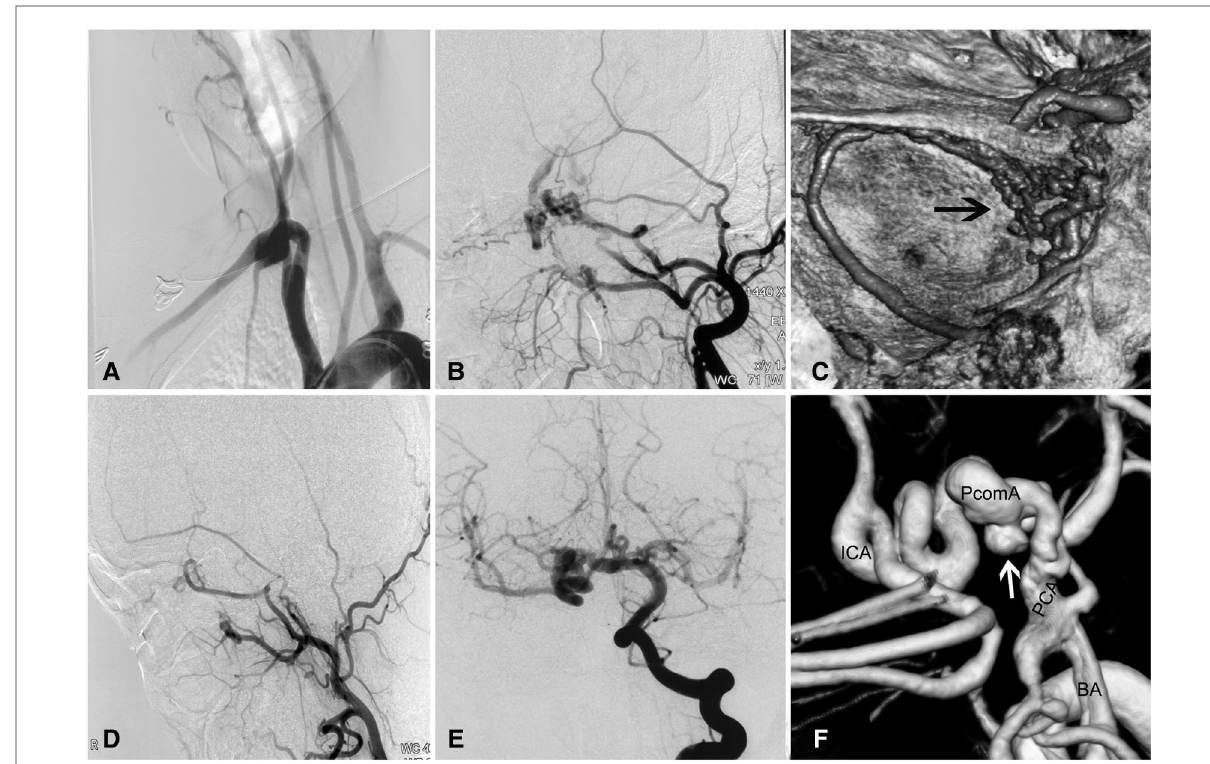
FIGURE 1 Complicated aneurysm of the posterior communicating artery with bilateral agenesis of the internal carotid artery in a 30-year-old woman. ( A ) Angiogram showing absence of bilateral ICAs. ( B ) Carotid rete mirabile between the external and internal carotid arteries on the left side, where there is ICA agenesis. ( C ) Reconstructed angiogram showing the rete mirabile located around the cavernous sinus. ( D ) No rete mirabile is present on the right side. ( E ) Injection of contrast in the right vertebral artery showing the posterior circulation providing blood supply to the anterior circulation via the right posterior communicating artery. ( F ) Reconstructed images showing the dolichoectatic posterior communicating artery harboring an aneurysm (white arrow). BA, basilar artery; ICA, internal carotid artery; PCA, posterior cerebral artery; PcomA, posterior communicating